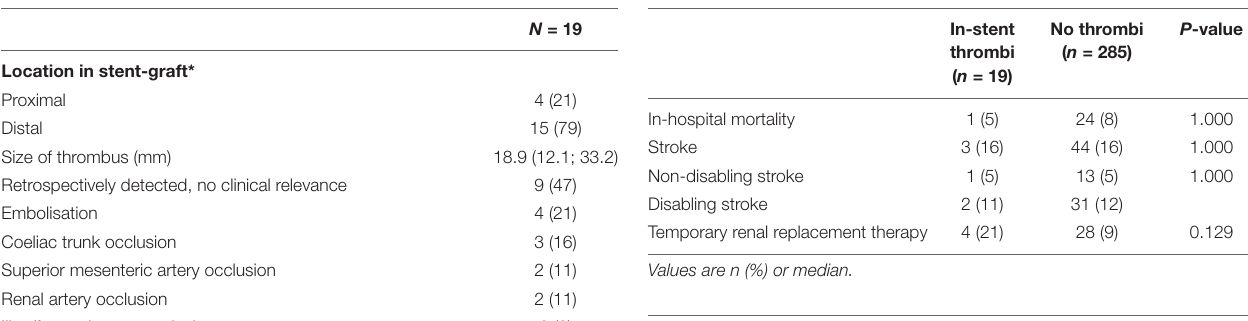
TABLE 5 | Logistic regression analysis—in-stent thrombus formation.